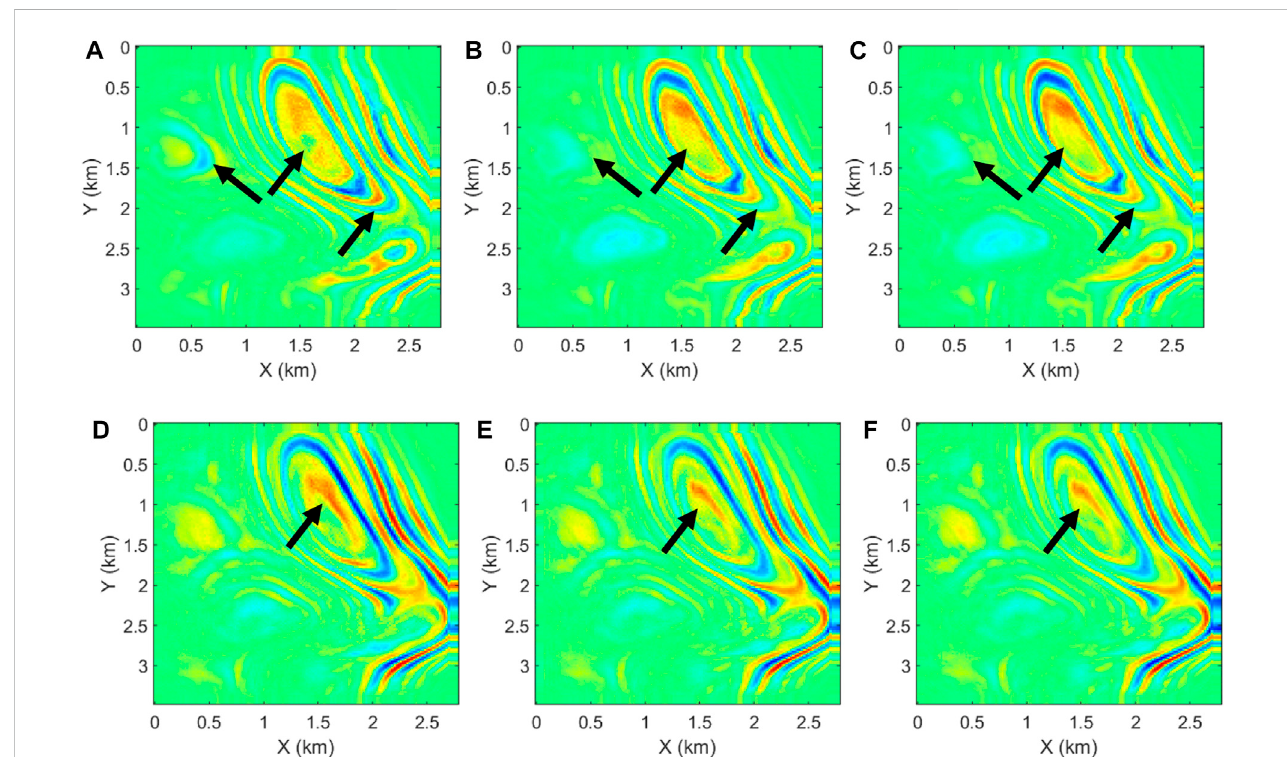
FIGURE 15 Imageslicesat z =1.2 kmusingthe (A) and (D) STSand (B) and (E) FTSmethodsand (C) and (F) references. (A) , (B) ,and (C) arePPimages,and (D) , (E) ,and (F) are PS images.